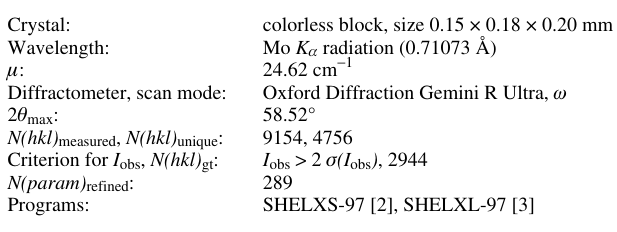
Table 1. Data collection and